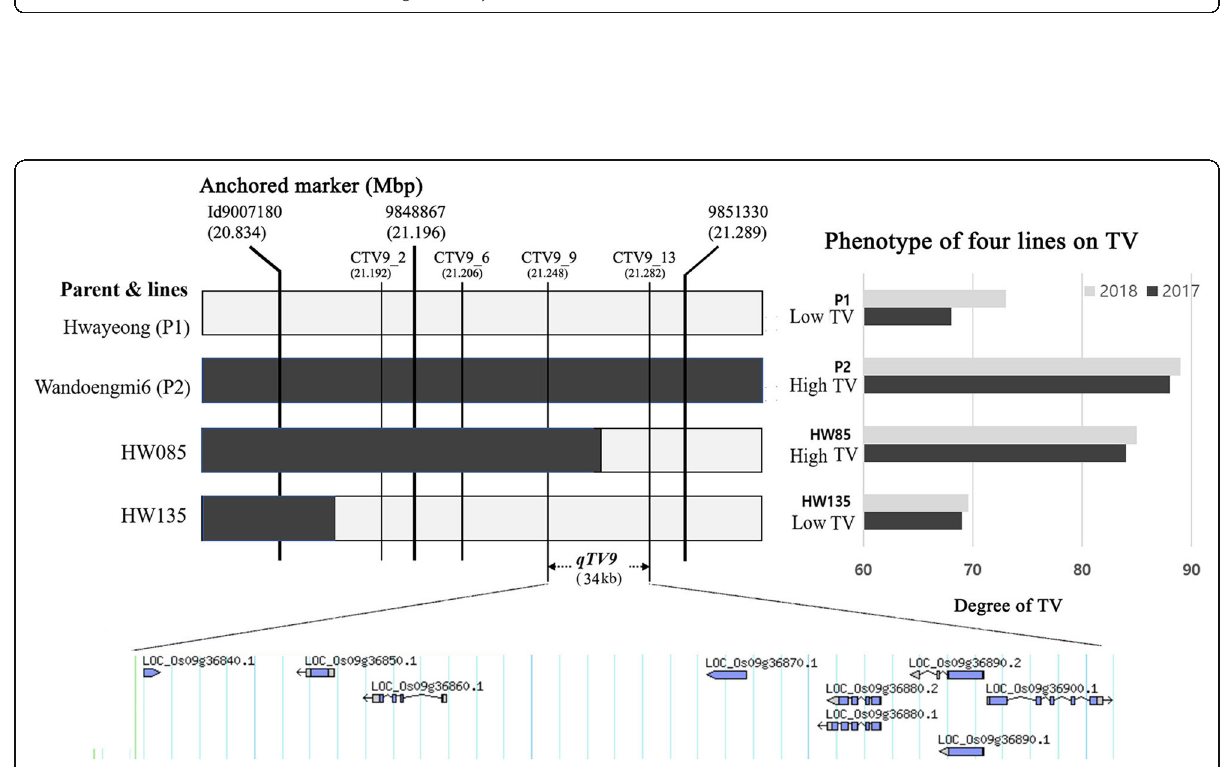
Fig. 3 Distribution of the QTL, qTV9 , on the scatter plot of taste value and overall eating quality (OE) for correlation analysis. The green spots indicate lines with qTV9, and the red spots indicate lines without the QTL. The linear lines on the plot show the correlations for significance between the taste value and OE of lines distinguished by the two colors